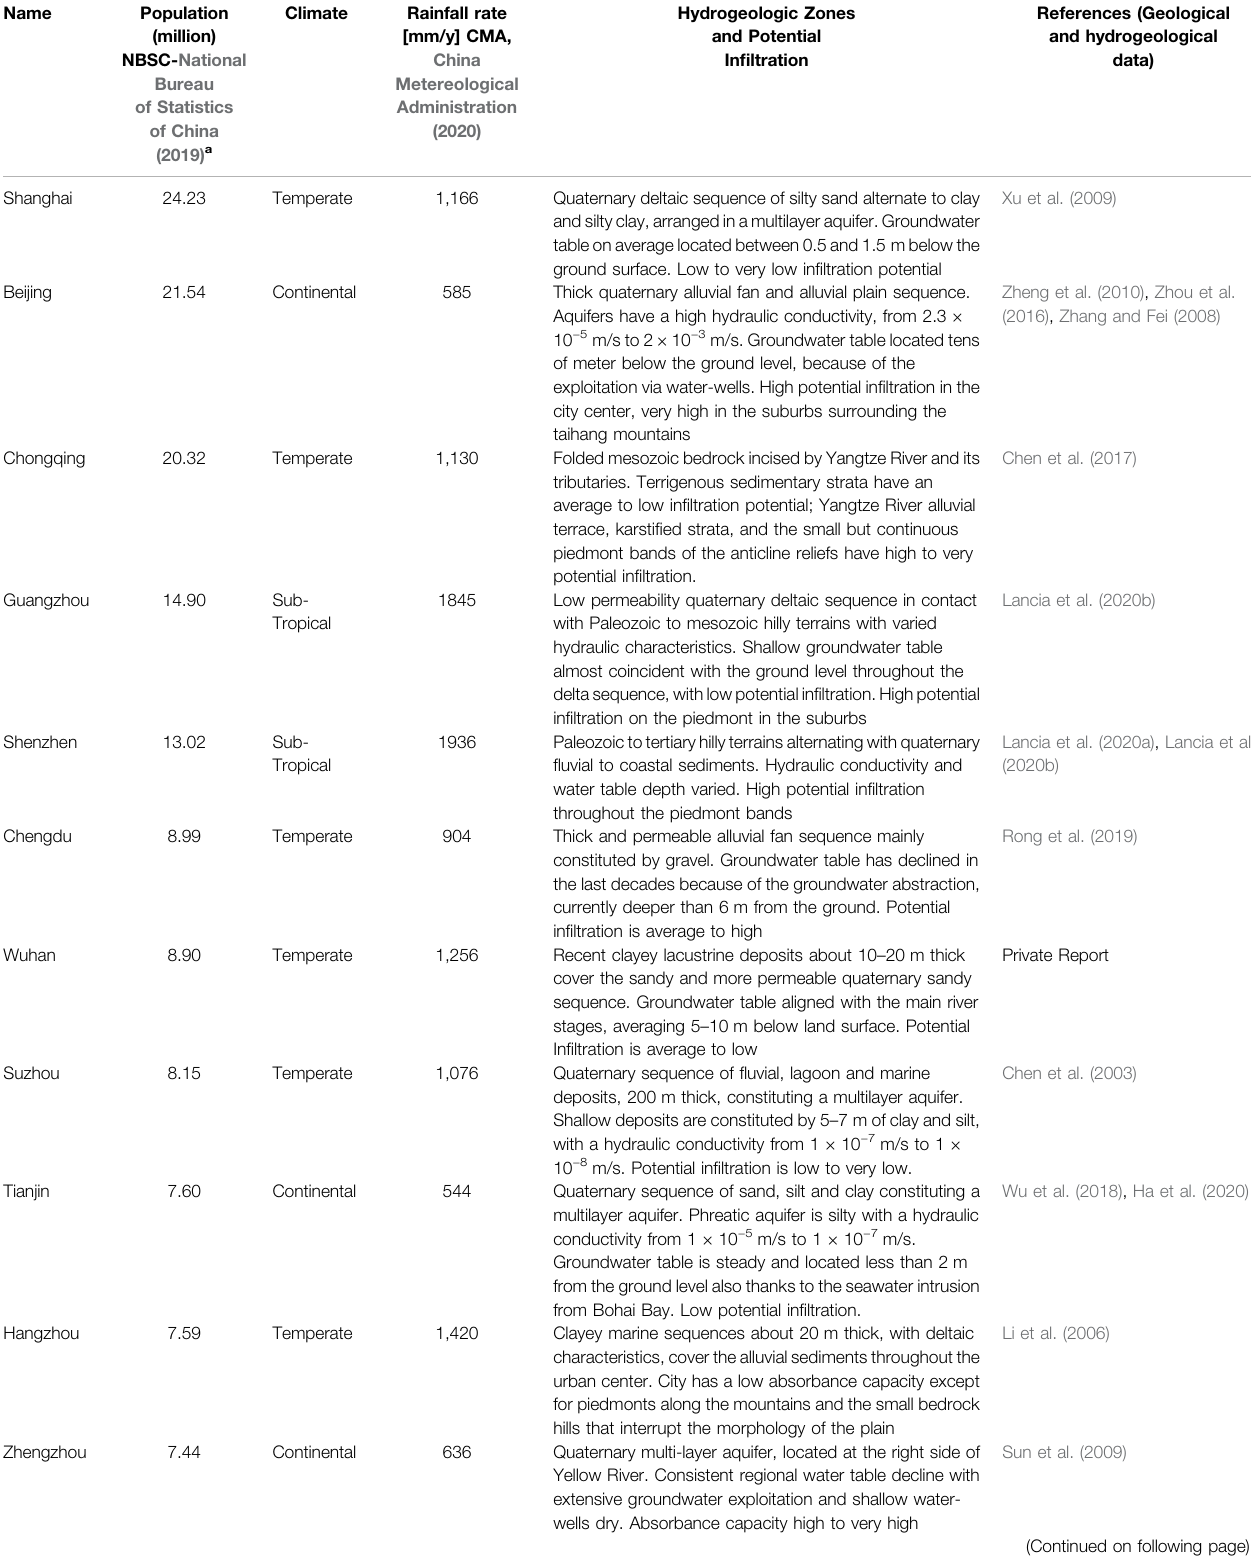
TABLE 1 | Hydrogeological characteristics and absorbance capacity of the 17 most populous Chinese cities.